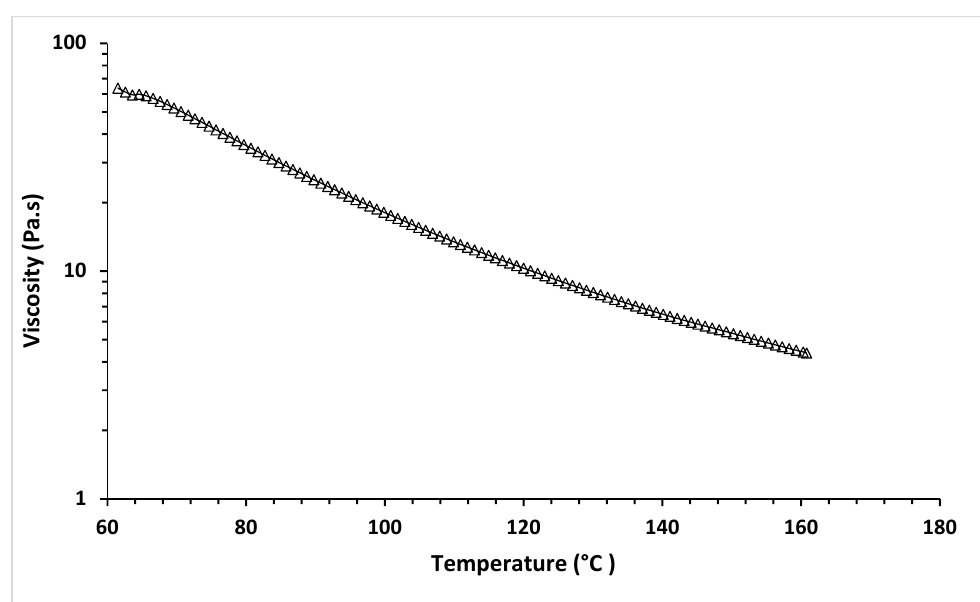
Figure 12. Temperature sweep of rheological test of MCL-PHA biomaterial-ink.